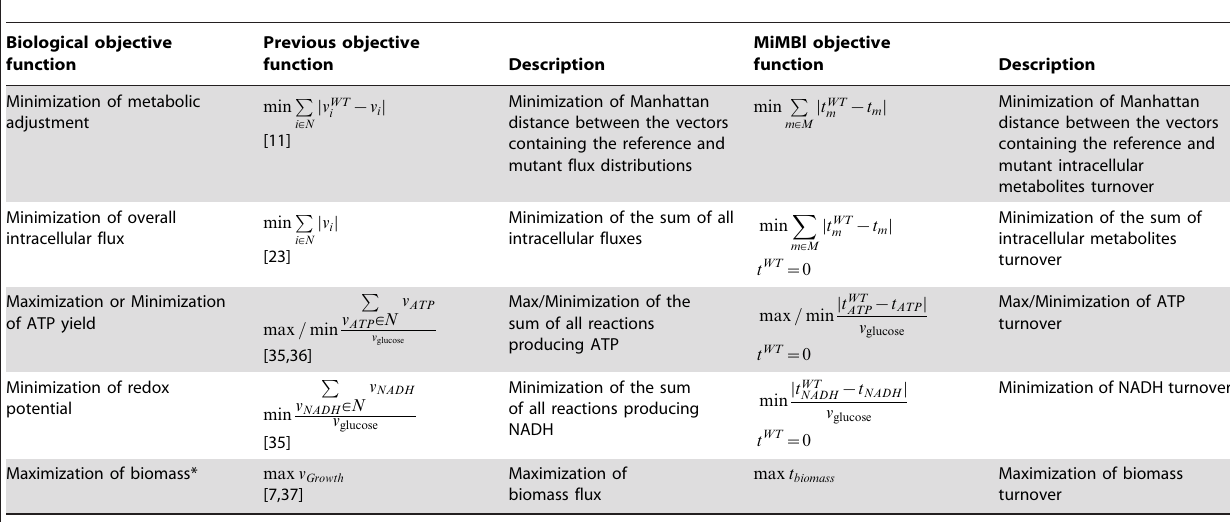
Table 1. Formulation of different biological objective functions using